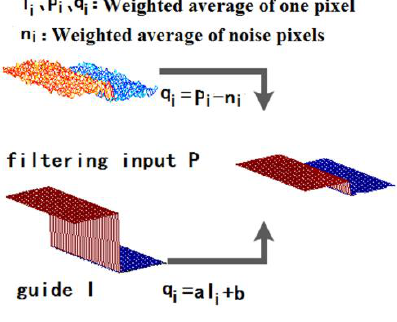
Figure 2. The guided filtering process.